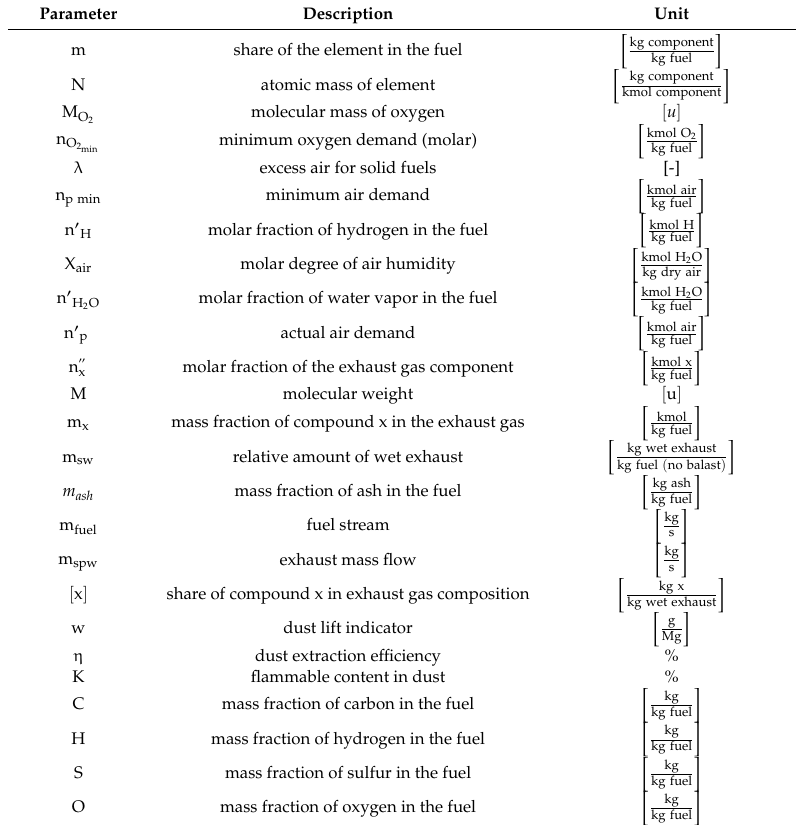
Table 2. Symbols and units used in calculations